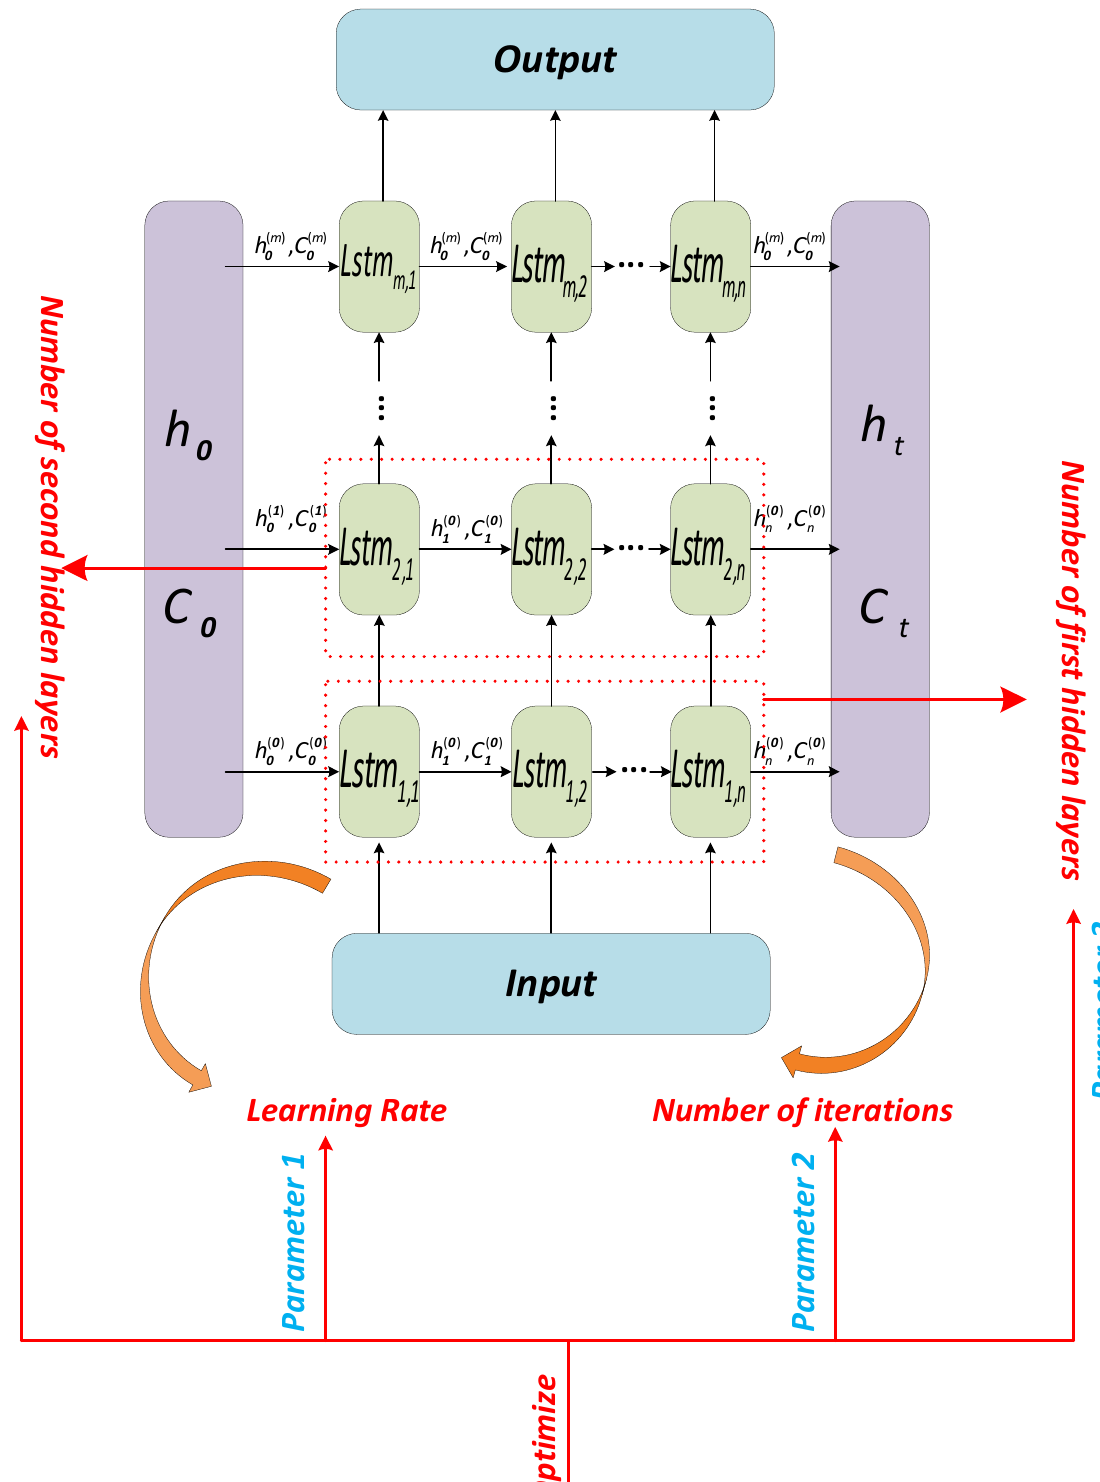
Figure 5. MetaREC_LSTM